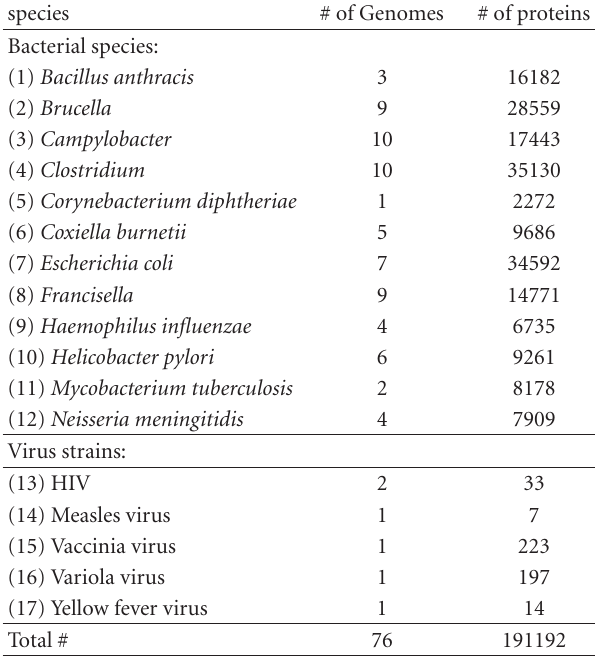
Table 1: Pathogens currently analyzed by Vaxign.